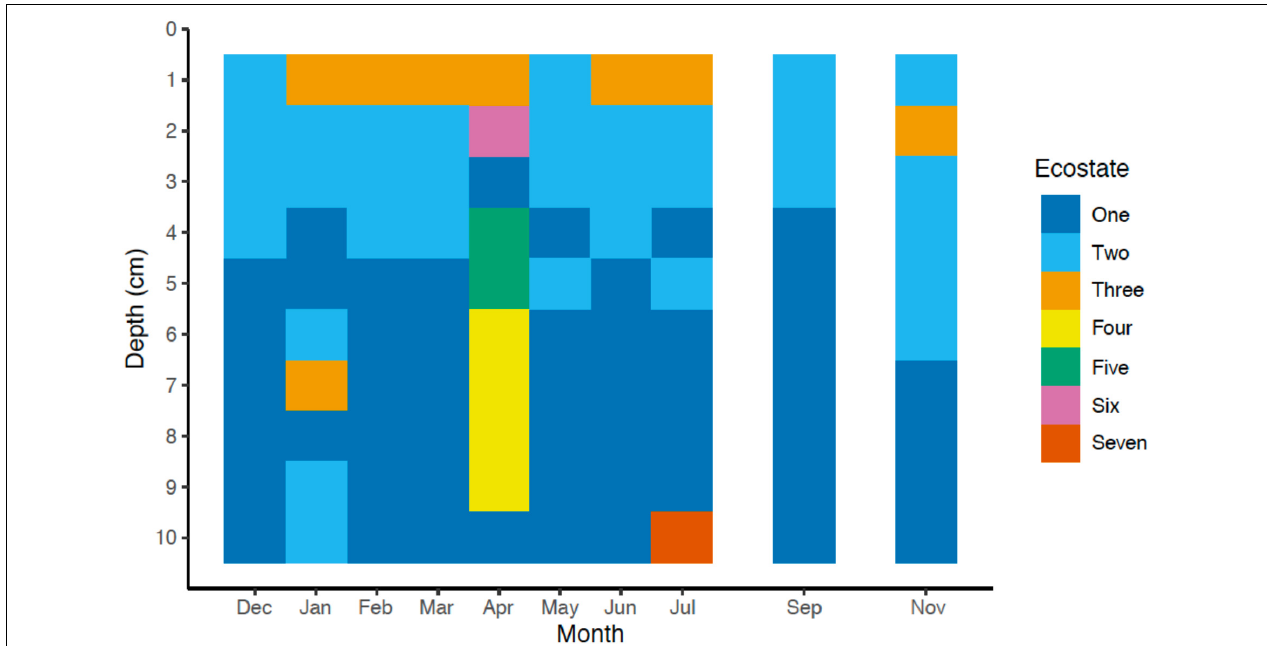
FIGURE 6 | Ecostates ( n = 7) of bacterial and archaeal microbial communities across one seasonal cycle. The seven different ecostates were identified from the Bray-Curtis dissimilarity matrix of the relative abundance of all OTUs ( n = 12,437) by average linkage hierarchical clustering. Taxonomic assignments of all taxa with a relative abundance ≥ 1.0% for each ecostate are shown in Supplementary Table 2